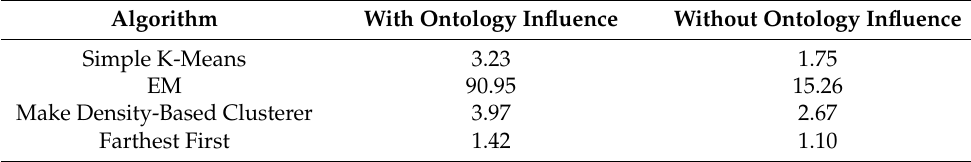
Table 4. Time in seconds to build the model on Artificial Reviews Dataset.